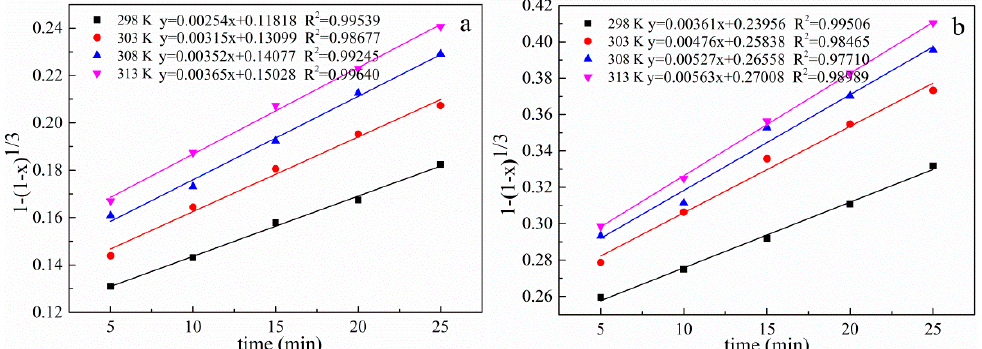
Figure 18. Plot of 1 − (1 − x)1/3 versus time for different temperatures under conventional and ultrasonic conditions. ( a ): under conventional conditions; ( b ): under ultrasonic conditions.